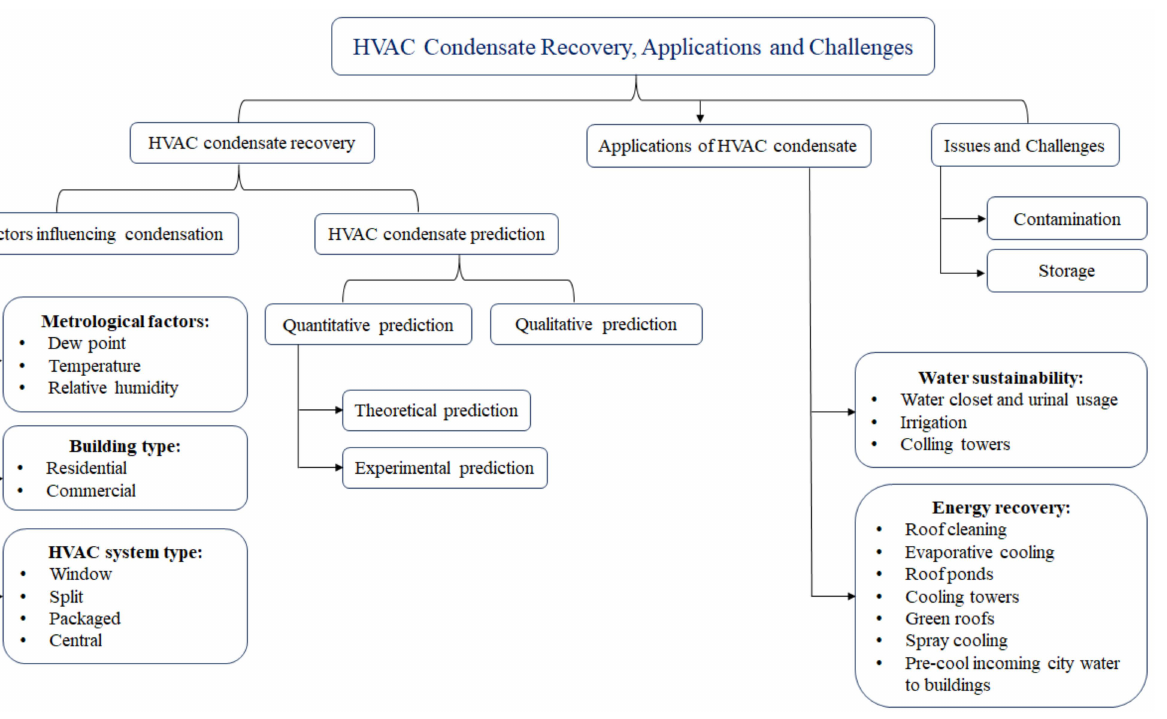
Figure 7. Overview of HVAC condensate recovery, applications, and challenges. Reprinted with permission from